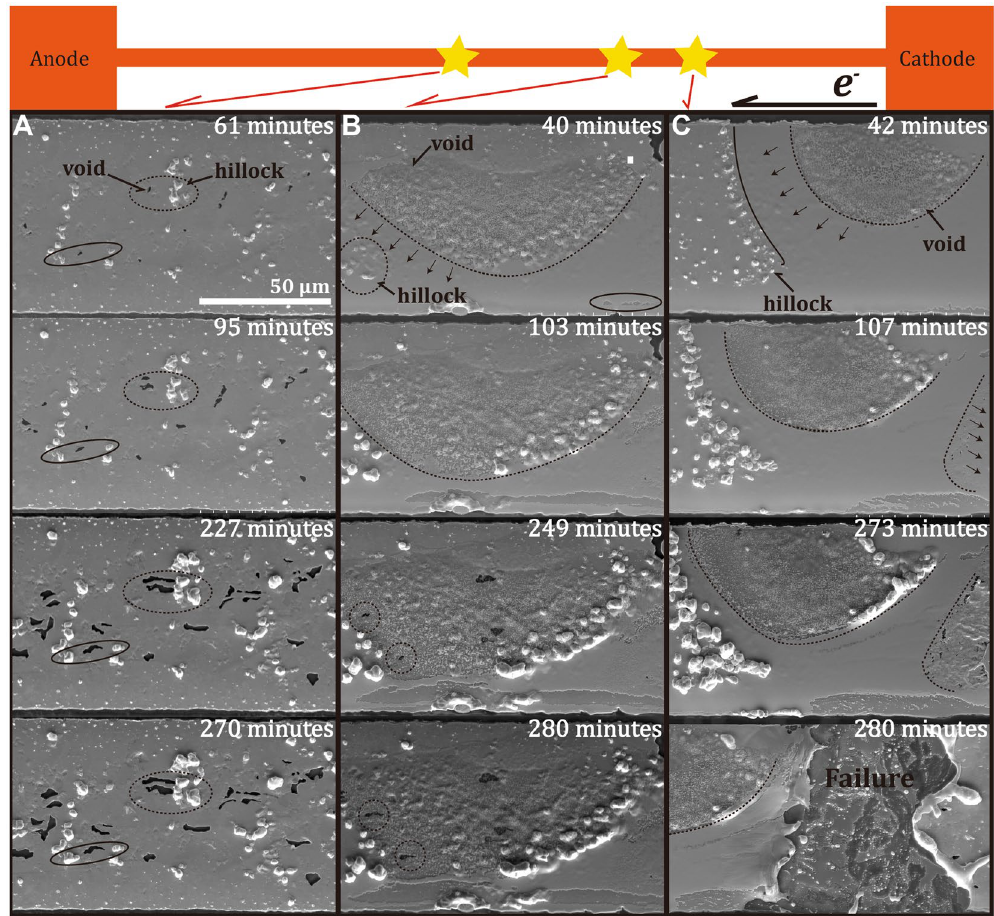
Figure 6. The morphology evolutions of the 80 μ m-wide Cu strip under current stressing at the current density of 1.0 × 10 6 A/cm 2 at the positions indicted in the schematic diagram with points A, B and C (the videos of in situ morphology evolution are available in supplementary).